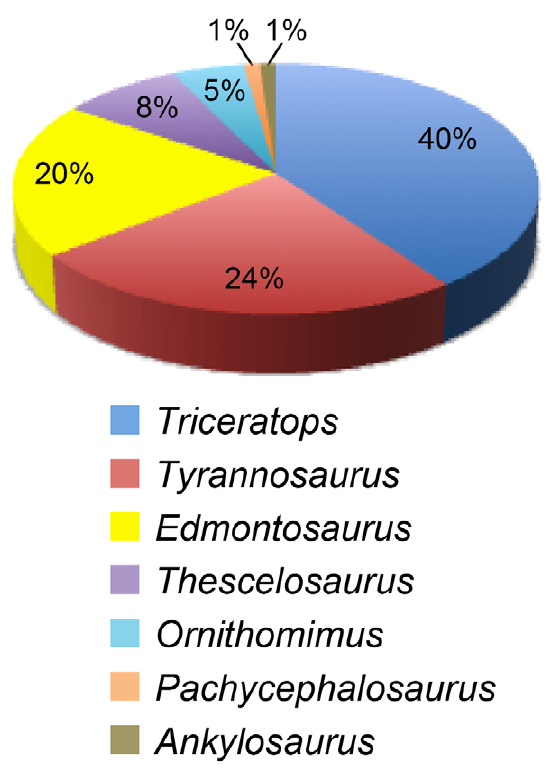
Figure 4. Pie chart of the time averaged census for large- bodied dinosaurs from the entire Hell Creek Formation in the study area. Triceratops is the most common dinosaur at 40% (n=72); Tyrannosaurus is second at 24% (n=44); Edmontosaurus is third at 20% (n=36) followed by Thescelosaurus at 8% (n=15), Ornithomimus at 5% (n=9), and Pachycephalosaurus and Ankylosaurus at 1% (n=2).